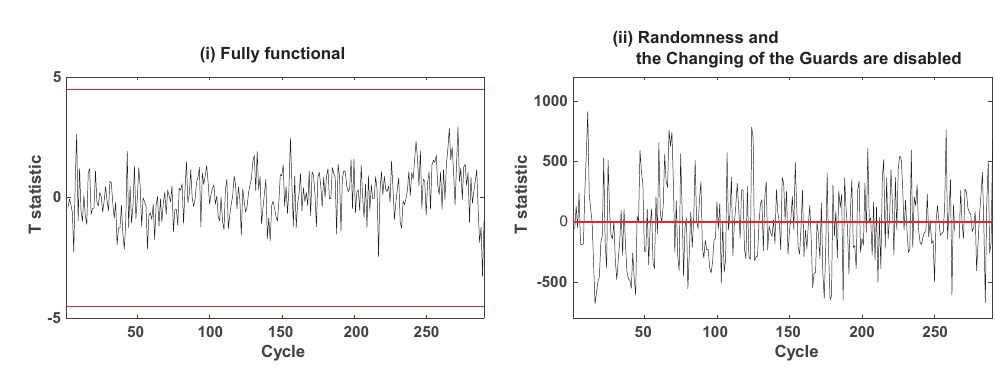
Figure 10: Results of the simulation-based leakage assessment. Horizontal: T-statistics, vertical: cycle. Subgraphs (i) and (ii) correspond to two different operating